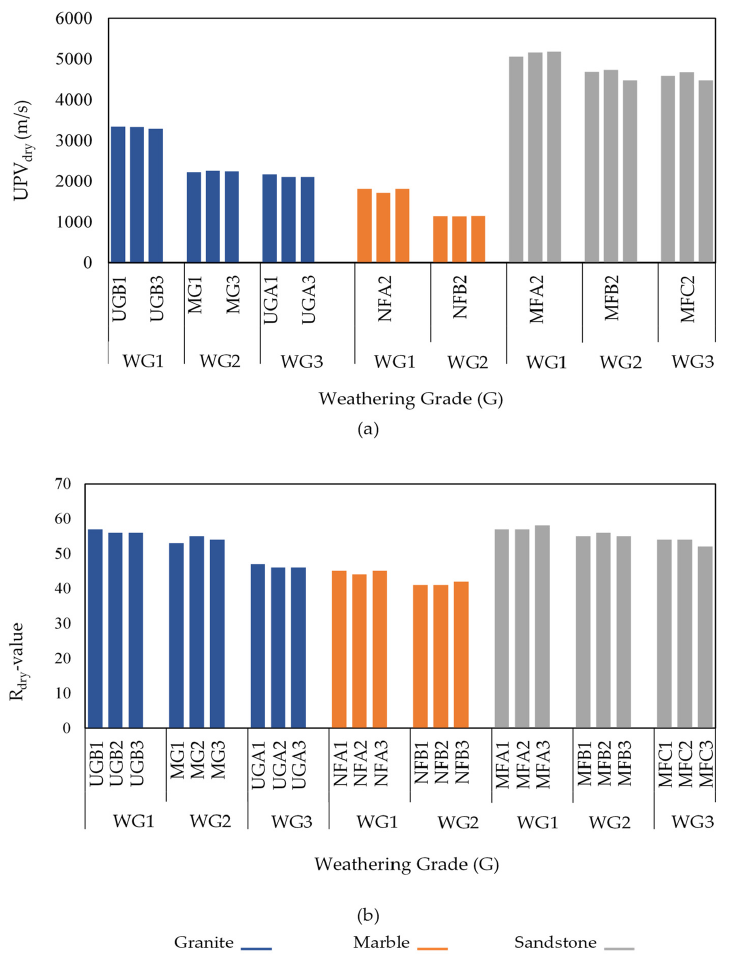
Figure 4. Variation of weathering grade ( a ) with UPV dry ( b ) with R dry